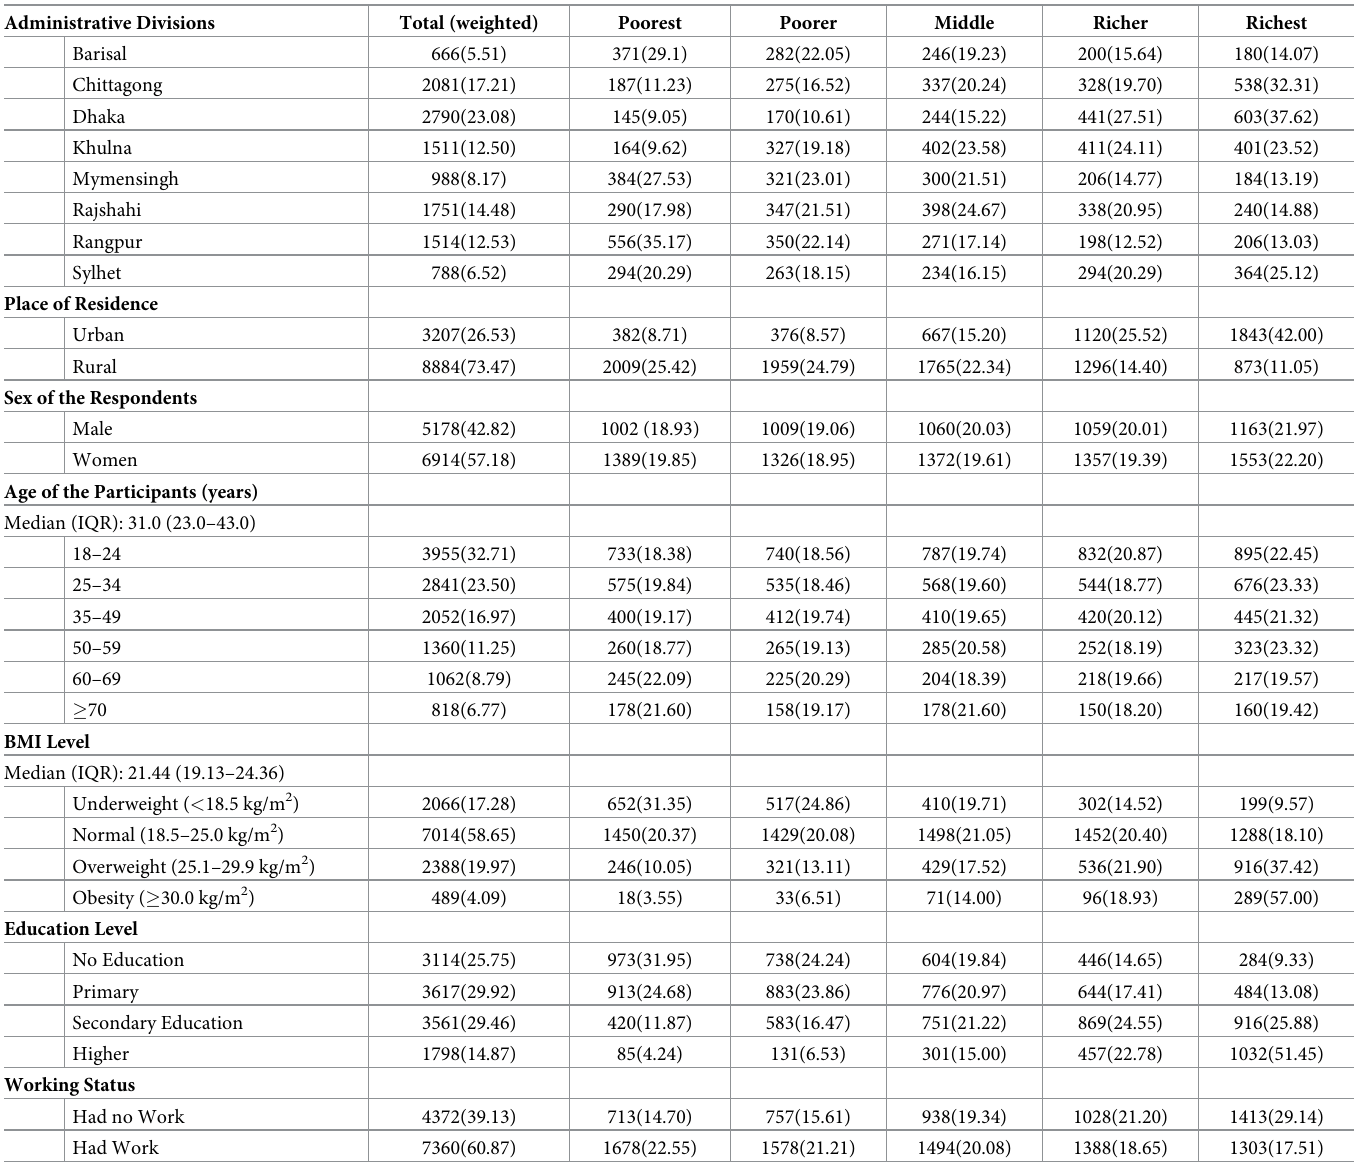
Table 1. General characteristics of the analyzable objects